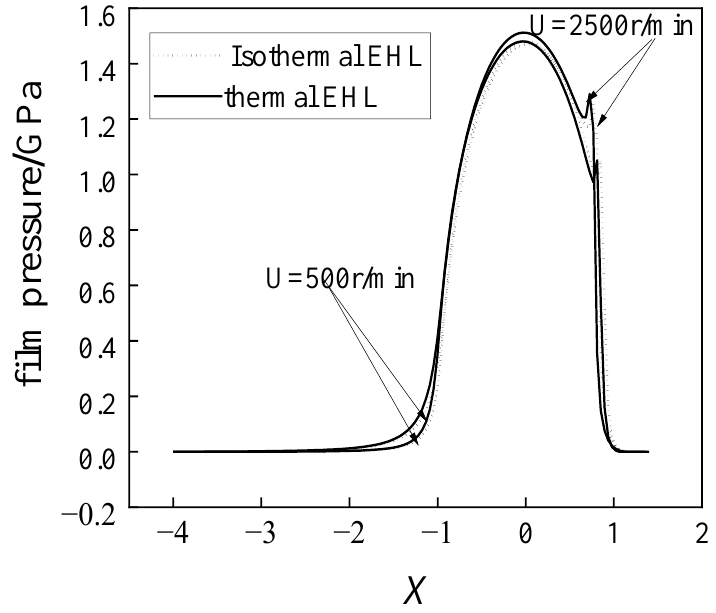
Figure 7. Influence of velocity on oil film pressure distribution.